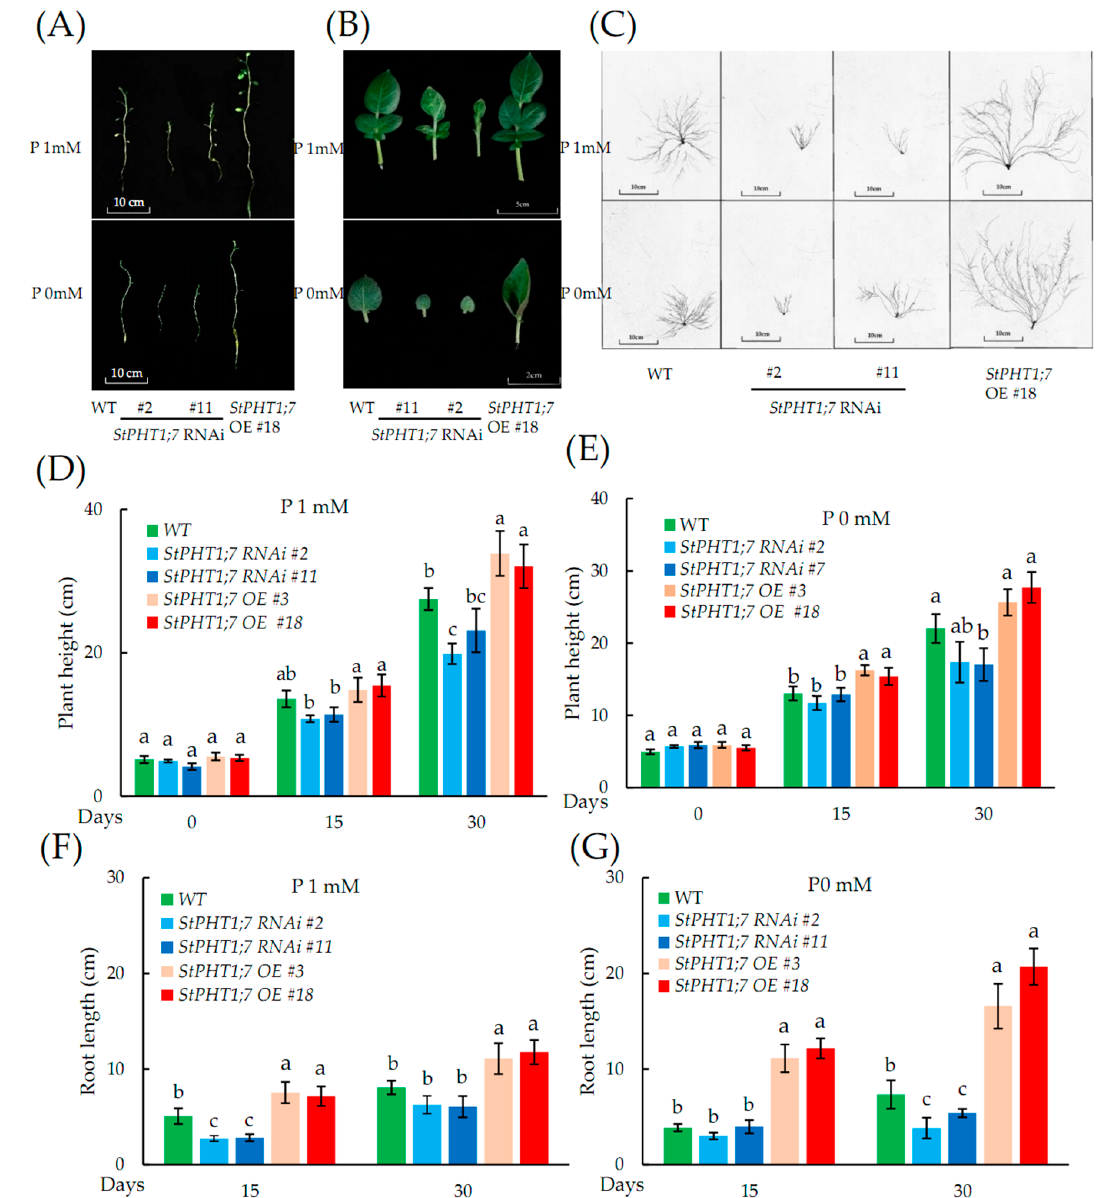
Figure 9. Changes in plant height, root length, and leaf shape among di ff erent transgenic potato lines under phosphorus-free conditions. “P1mM” indicates normal P content (1 mM) cultivation, while “P0mM” indicates phosphorus-free content (0 mM) cultivation. ( A ) Phenotypes of potato plants in Hoagland hydroponics at 30 days; ( B ) the phenotype of the third fully expanded leaves of potato plants under the conditions of Hoagland hydroponics at 30 days; ( C ) roots of different transgenic potato lines at 30 days of P stress; ( D ) the plant height of different transgenic potato lines under normal P content (1 mM) cultivation; ( E ) the plant height of different transgenic potato lines during P-free stress cultivation; ( F ) the root length of different transgenic potato lines during normal P content (1 mM) cultivation; ( G ) the root length of different transgenic potato lines during P-free stress cultivation. Each value is expressed as mean ± SD ( n = 9, 9 biological repeats). Different lowercase letters in the same column represent significant differences ( p ≤ 0.05) using Duncan’s multiple range test, respectively.